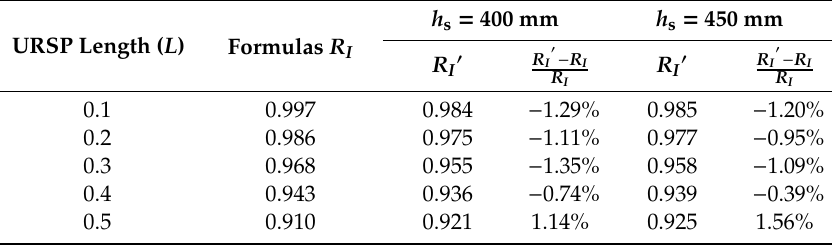
Table 5. R I of middle joints under load case